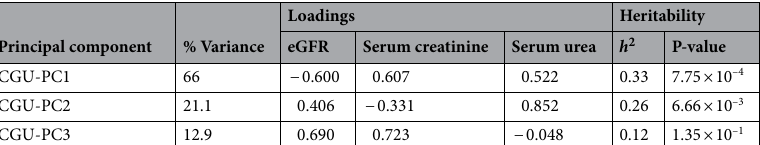
Principal component % Variance